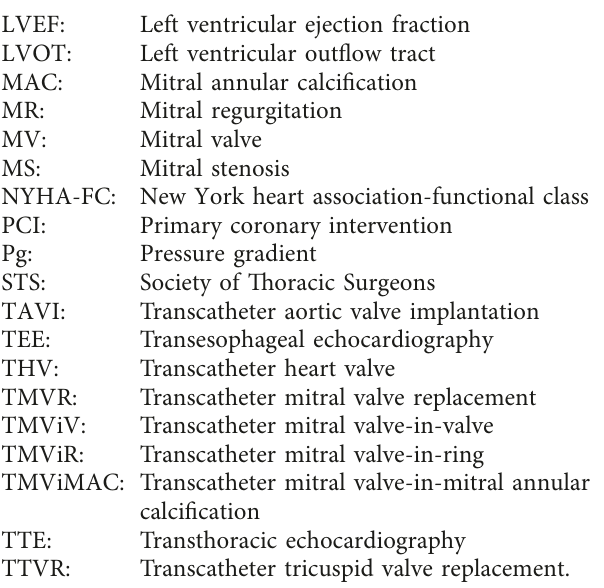
Supplementary table: comparison between this study and the Society of Thoracic Surgeons/American College of Cardi- ology/Transcatheter Valve Therapy (STS/ACC/TVT)